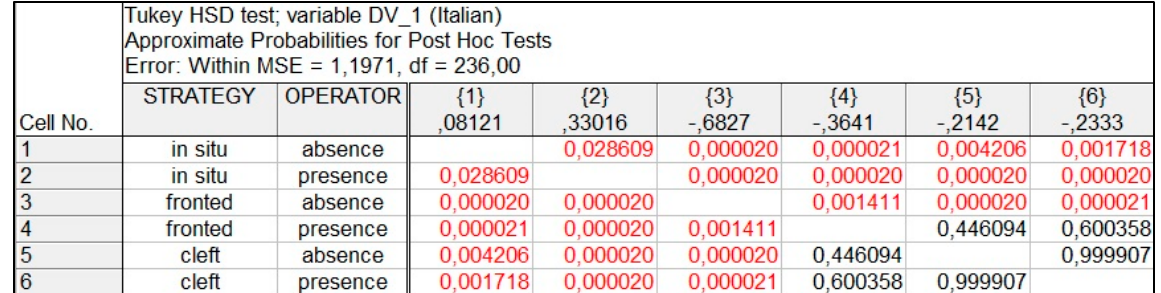
Figure 20. Strategy*Operator interaction (Italian) .